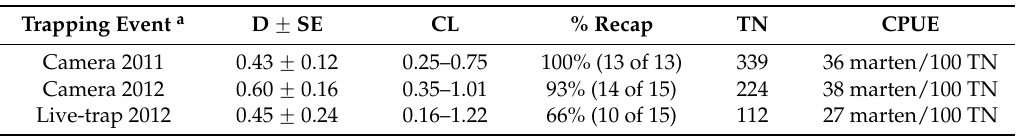
Table 1. Associated density (D ˘ SE) of martens/km 2 , 95% confidence limits (CL) for top camera- and live-trap spatial capture–recapture (SCR) models. The proportion recaptured (% Recap), trap nights (TN), and catch-per-unit-effort (CPUE) are included for each capture